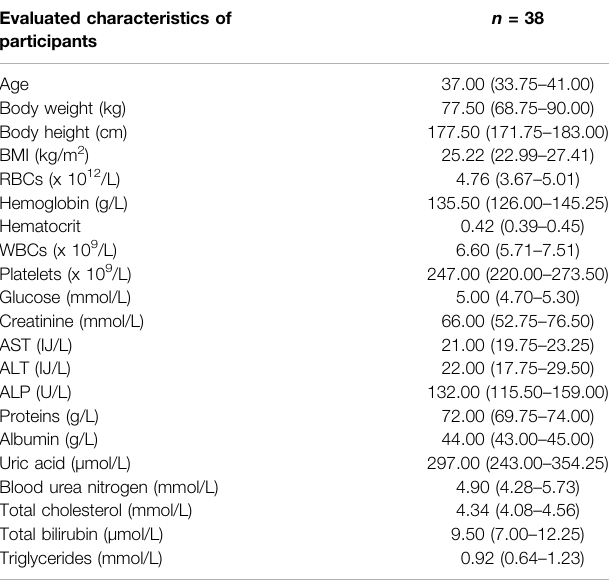
TABLE 1 | Demographic, clinical, and laboratory characteristics of participants. Evaluated characteristics of participants